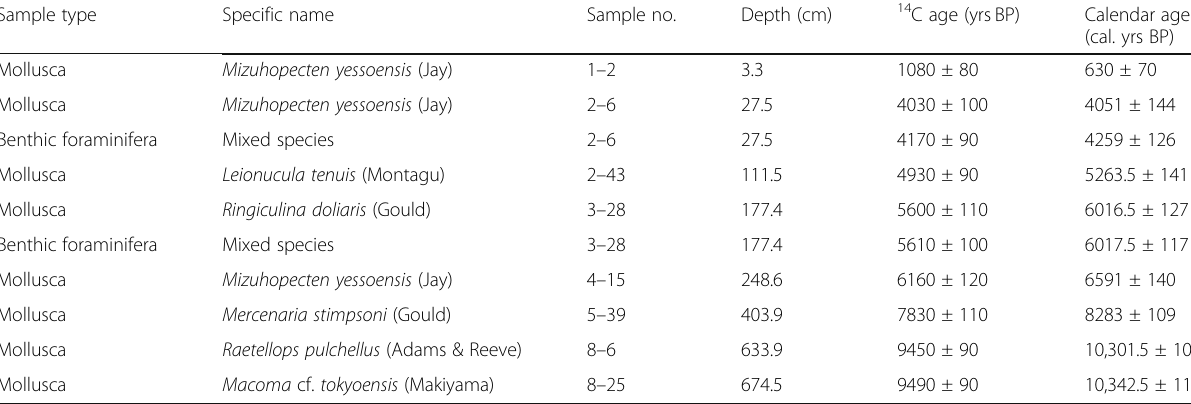
Table 1 Sampled species, core depths, and results of radiocarbon dating Sample